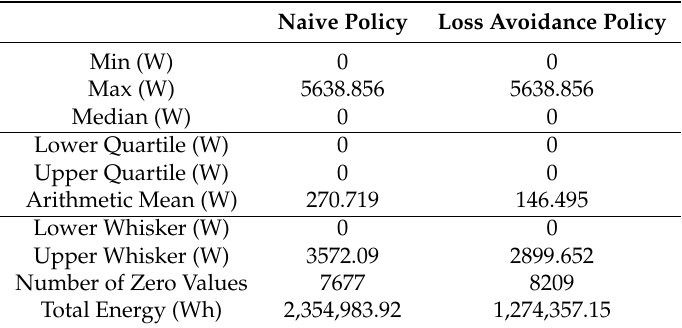
Table 8. Obtained statistical values of Figure